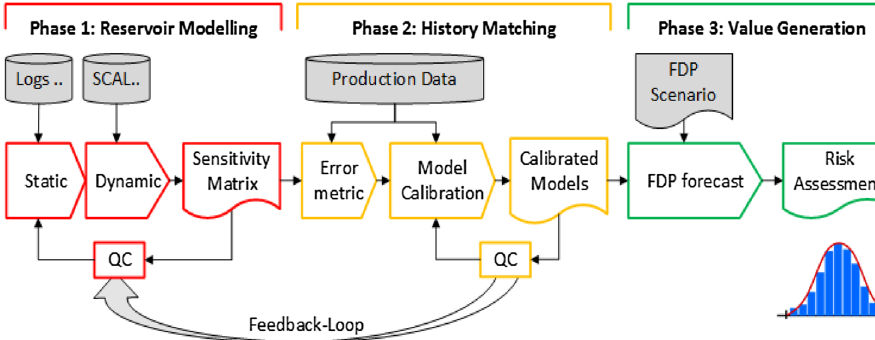
Fig. 2 Generic workflow for